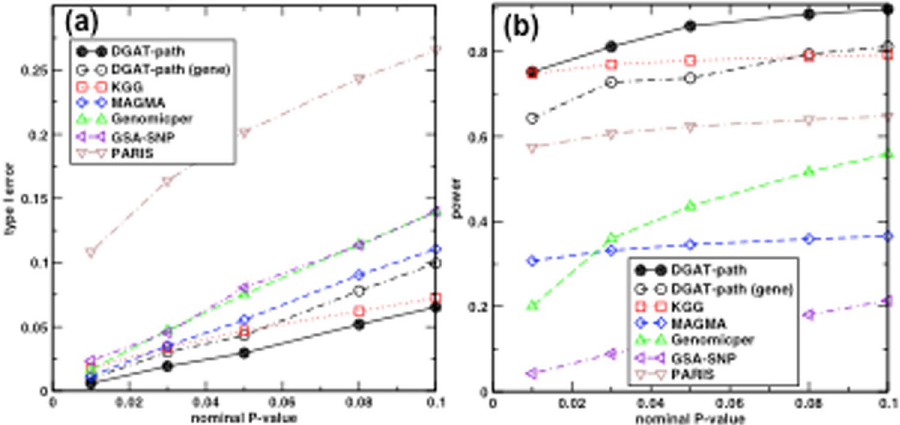
Figure 2. Comparisons of methods by ( a ) the type I error rate and ( b ) the power at different nominal P-values.